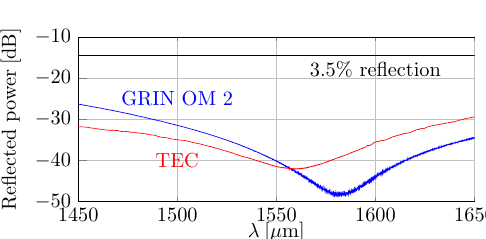
Figure 3. Measured back-reflection of SMF-GRIN and SMF-TEC MFAs as a function of